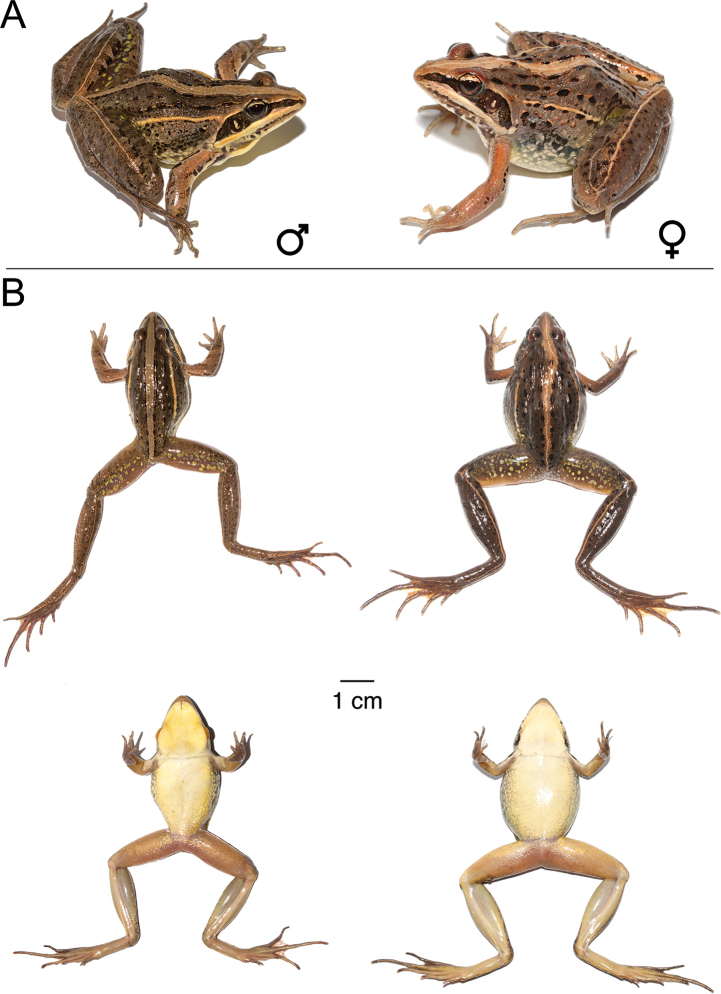
Ptychadena
goweriA Live male (SB99; left) and female (SB5807, right) B dorsal and ventral views of the same individuals (male left, female right) after euthanasia and before fixation.